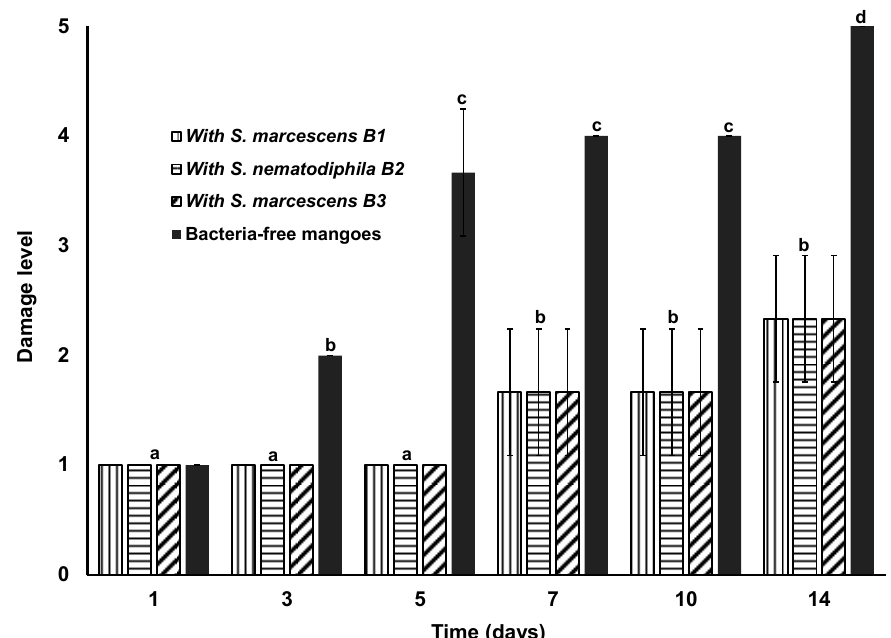
Figure 3. Mangoes with lesions inoculated with C. siamense and treated with strains of Serratia . The damage level means, 1: between 0 to 1% of damage; 2: between 1 to 5% of damage; 3: between 6 to 9% of damage; 4: between 10 to 49% of damage and 5: between 50 to 100% of damage. Different letters in the columns on the different days of treatment mean a statistically significant difference ( p < 0.05).